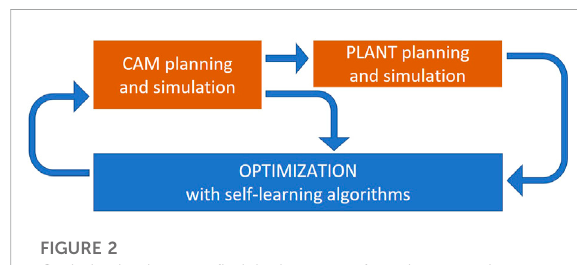
FIGURE 2 Optimization loops to fi nd the best manufacturing